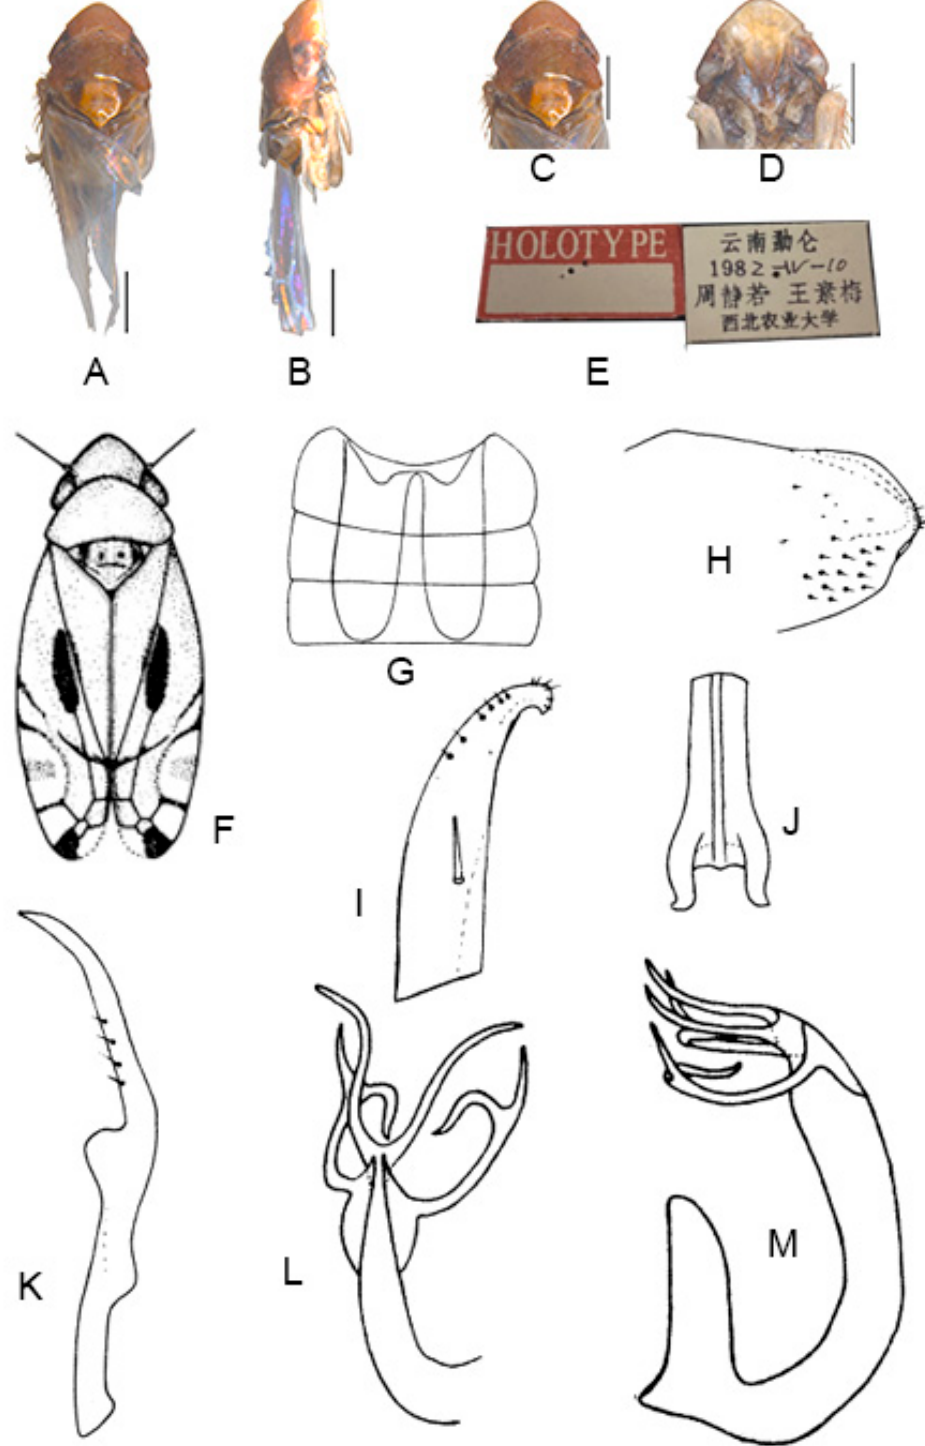
Figure 3. Eurhadina ( Singhardina ) menglunensis . ( A – E : holotype; F – M : Huang et Zhang, 1999 [8]) ( A ) habitus, dorsal view; ( B ) habitus, lateral view; ( C ) head and thorax, dorsal view; ( D ) face; ( E ) labels of the holotype (China, Yunnan Prov., Menglun, 1982.IV.10, coll. Jingruo Zhou and Sumei Wang); ( F ) habitus, dorsal view; ( G ) abdominal apodemes, dorsal view; ( H ) male pygofer side, lateral view; ( I ) subgenital plate, dorsal view; ( J ) connective, dorsal view; ( K ) paramere, dorsal view; ( L ) apex of aedeagal shaft, dorsal view; and ( M ) aedeagus, lateral view. Scale bars: 0.5